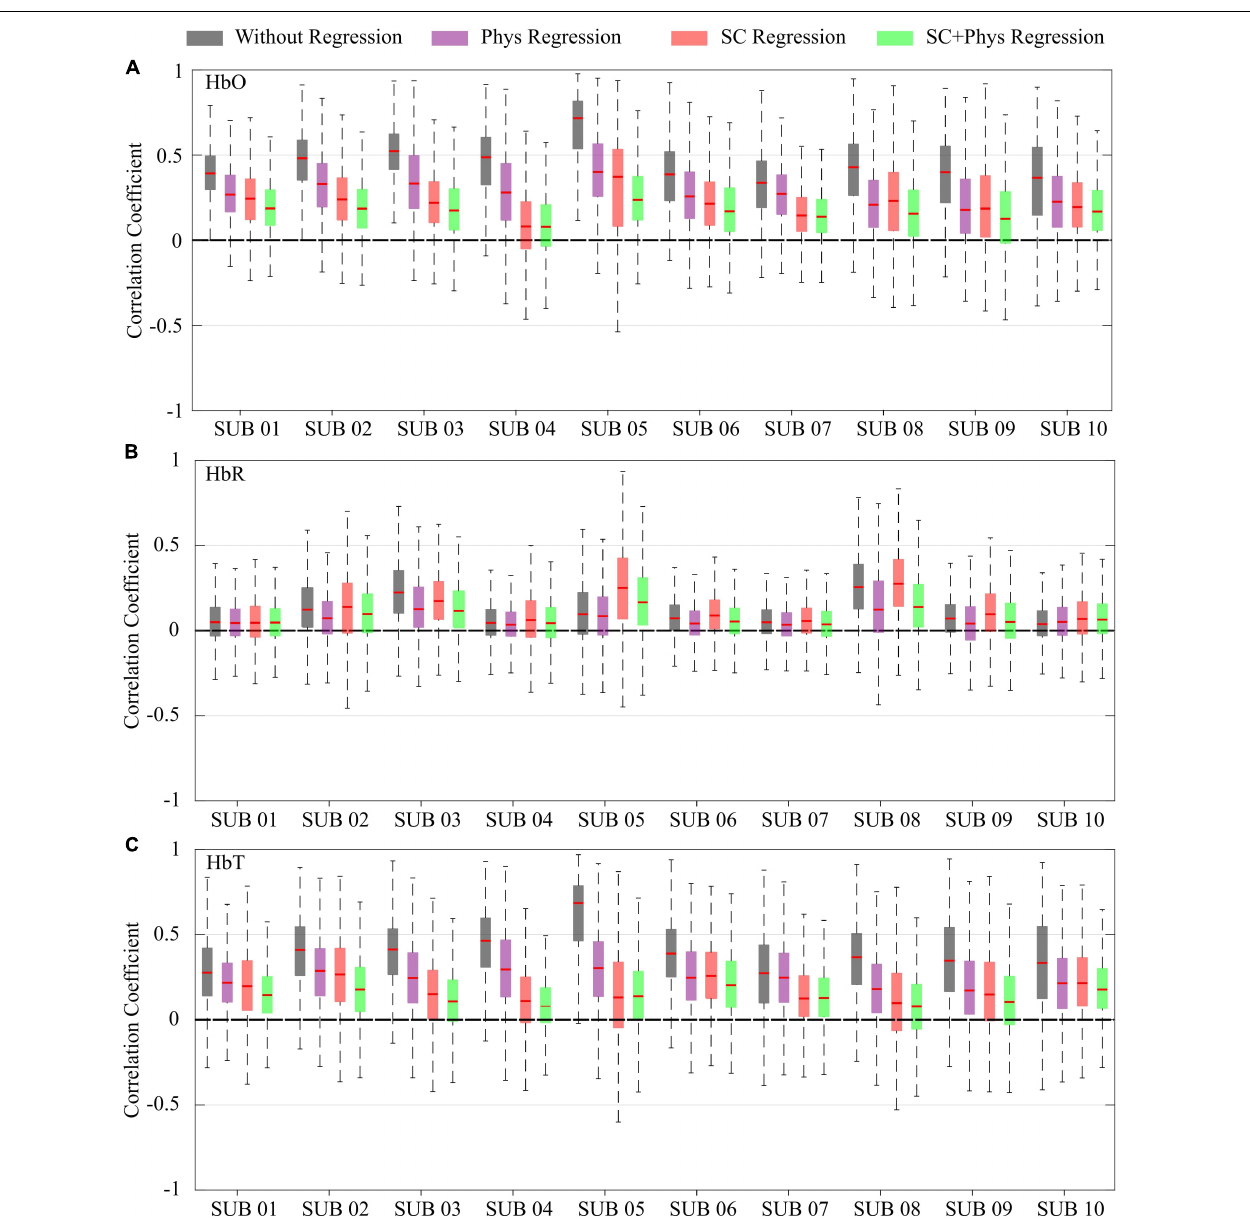
FIGURE 3 | Box plot for the correlation coefficients for each participant and preprocessing method for (A) oxy-hemoglobin (HbO), (B) deoxy-hemoglobin (HbR), and (C) total-hemoglobin (HbT) concentrations. The different colors correspond to different preprocessing approaches: no extracerebral regression (gray), after regression with additional physiological measurements (violet), after regression with short channels (red), and after regression with short channels combined with physiological measurements